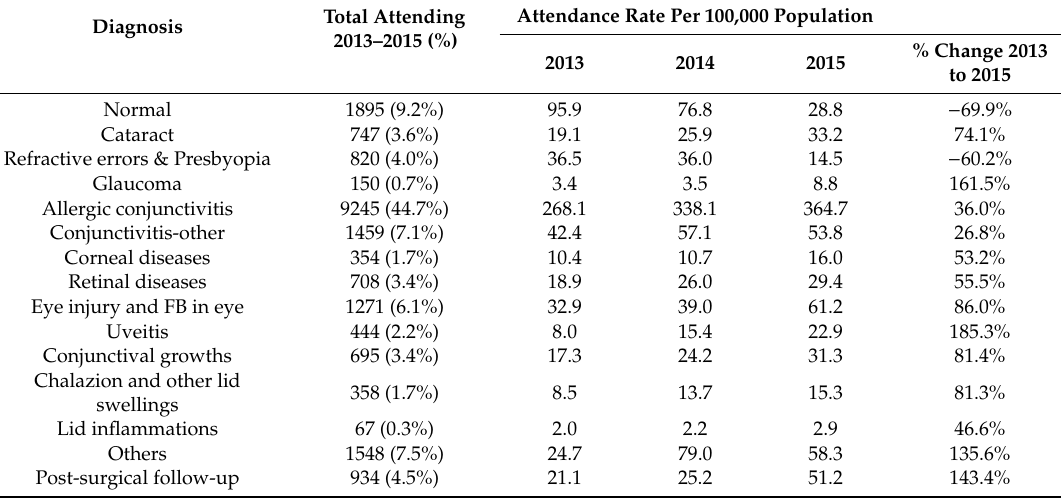
Table 4. Trends and percentage change in attendance rates to Kitale Eye Unit (standardized to population for respective year) by eye conditions in Trans Nzoia